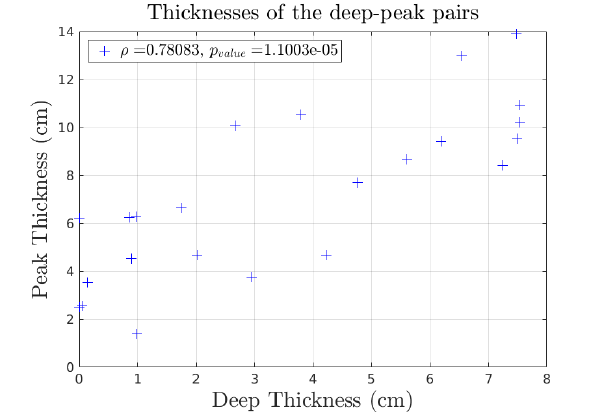
Figure 9. Thicknesses of the deep-peak pairs.